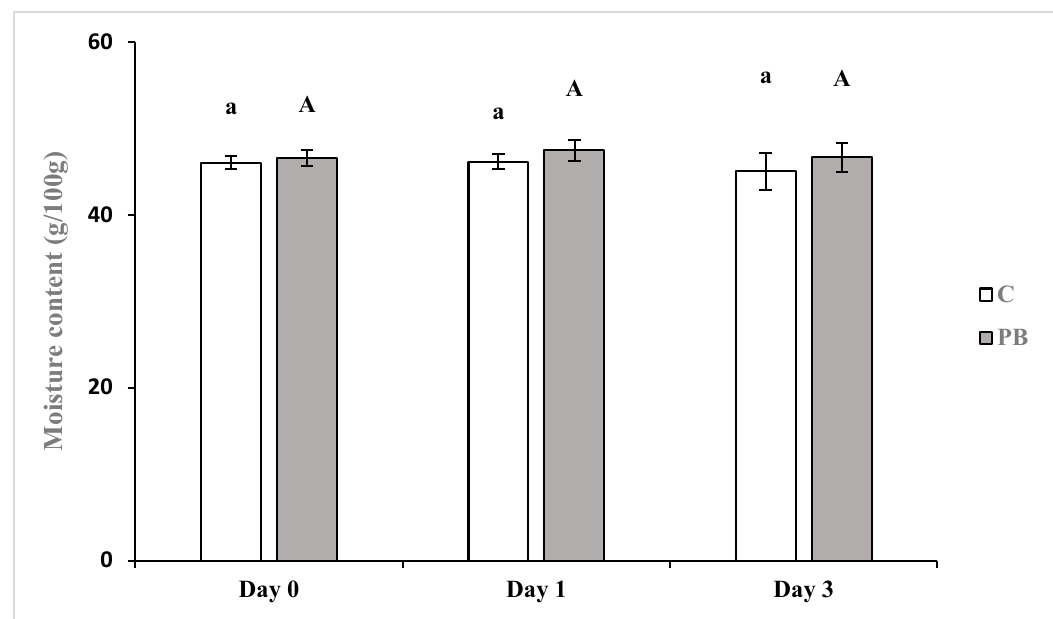
Table 1. Crust and crumb colorimetric parameters for control (C) and green coffee parchment (PB) breads a . Figure 2. Moisture content (g/100 g), mean and standard deviation, of control (C) and parchment supplemented (PB) breads.